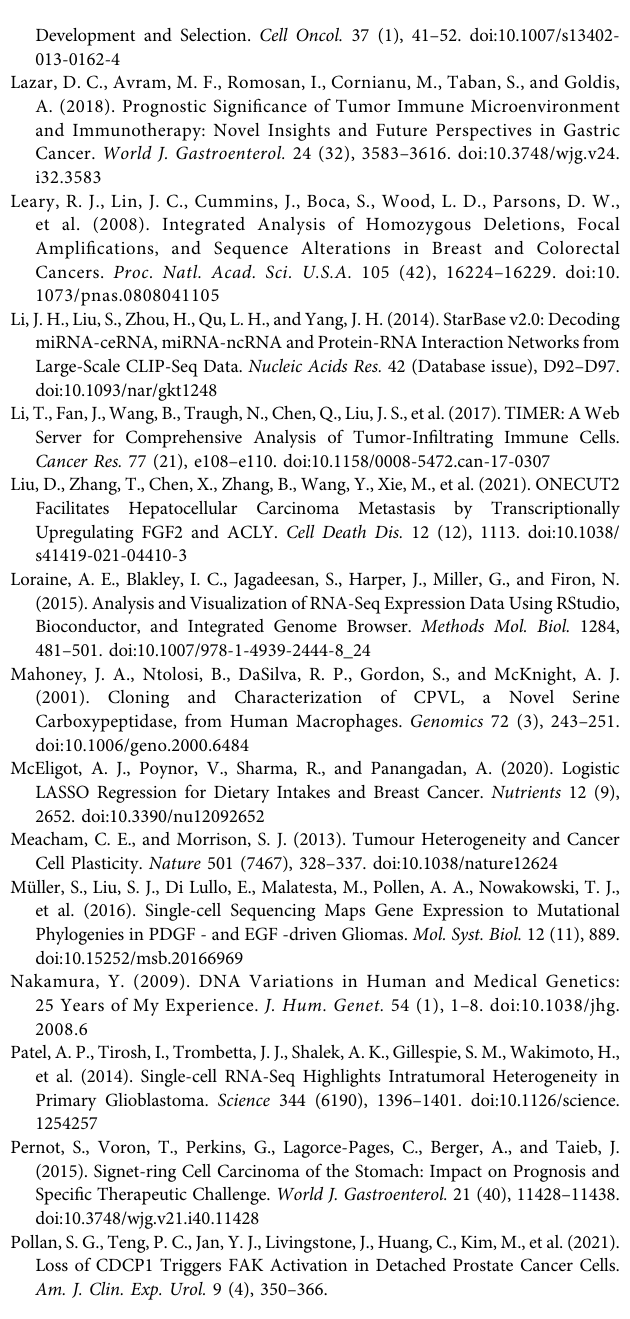
Supplementary Figure S4 | The scatter plot shows the correlation of CPVL with immune score and matrix score in pan-cancer. Supplementary Figure S5 | Relative expression levels of lncRNAs and miRNAs in gastric cancer cell